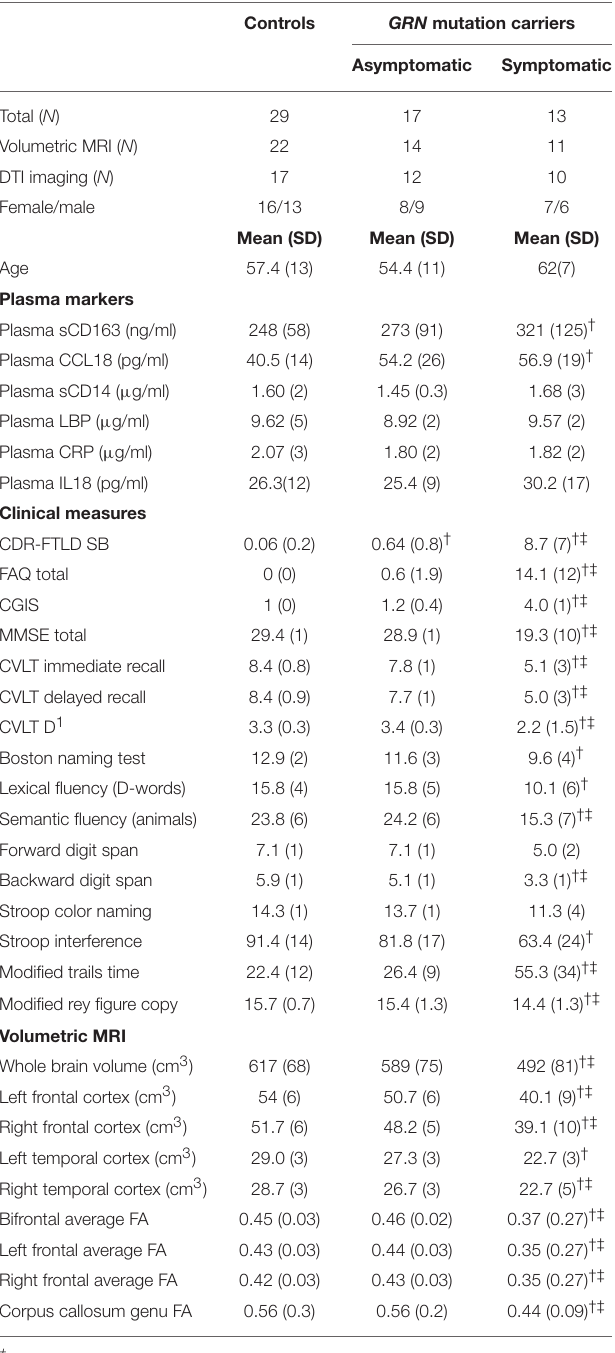
TABLE 1 | Patient demographics, plasma biomarkers, and radiographic measures. Controls GRN mutation